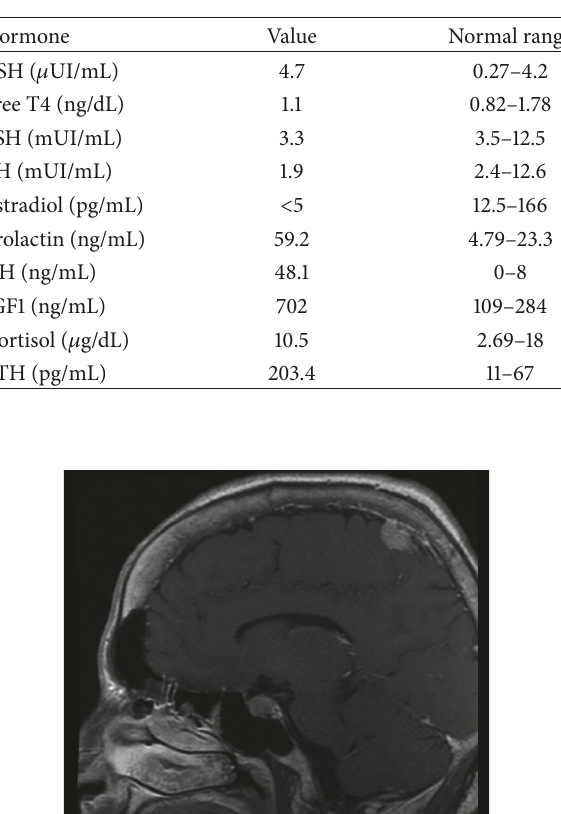
Table 1: Hormone measurements in plasma.